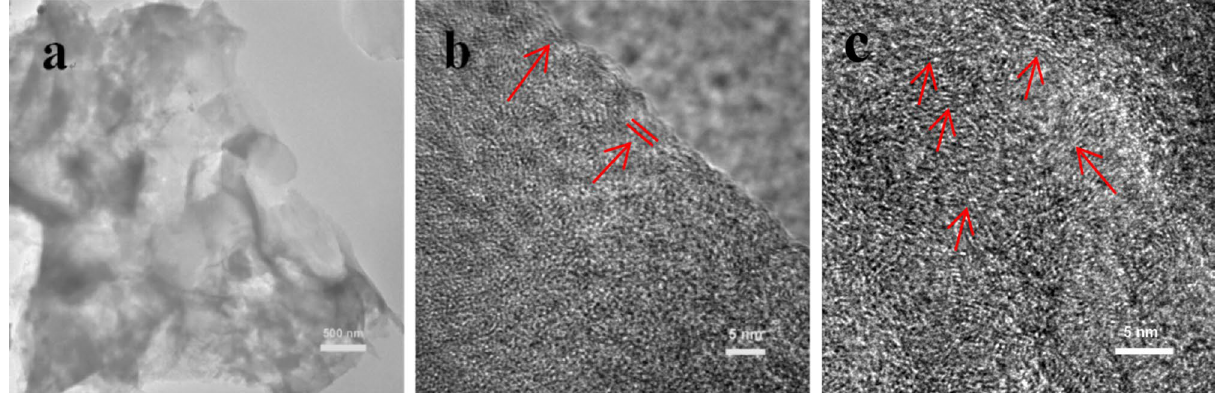
Figure 2. ( a , b ) TEM images of HPGC-750 under different magnifications; ( c ) TEM image of HPGC-800. Photographs compiled using Powerpoint 2019 (https:// www. micro soft. com/ zh- cn/ micro soft- 365/ get- start ed- with- office- 2019) without changing the content of images themselves.